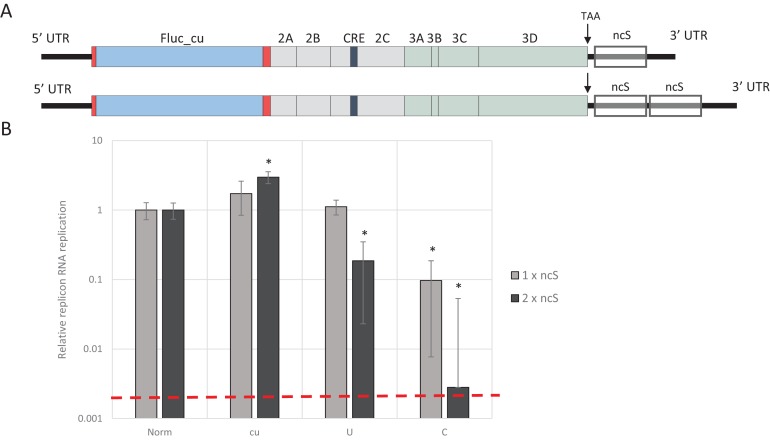
E7 replicon RNA replication is restricted by repeats of synthetic non-coding regions with increased UpA and CpG dinucleotides.(A) Schematic representation of E7 replicon with coding non-coding synthetic (ncS) repeats indicated. (B) RD cells were transfected with luciferase expressing E7 replicon RNA containing either a single (gray bars) or double (black bars) ncS repeat of either normalised (Norm) CpG and UpA low (cu) UpA high (U) or CpG high (C) composition. Luciferase expression was measured at 6 hpt. Bars are normalised to their respective E7 replicon with randomised nucleotide composition, but WT dinucleotide frequencies (Norm). Error bars represent one standard error of the mean and the dashed line displays the level of luciferase expression from non-replicative guanidine treated samples. Asterisks indicate significant difference from the respective single or double Norm ncS, p-value *<0.01, T-test.